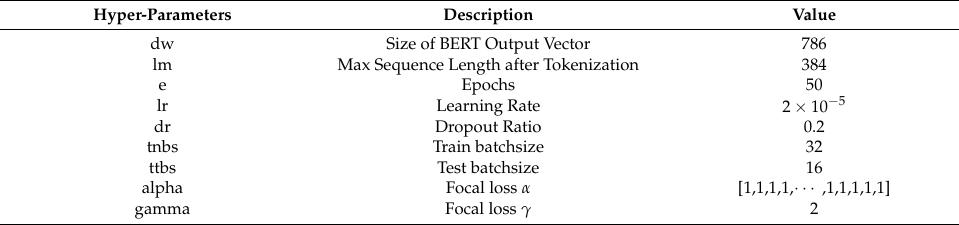
Table 6. Hyperparameter settings for our model on the KBP37 dataset.